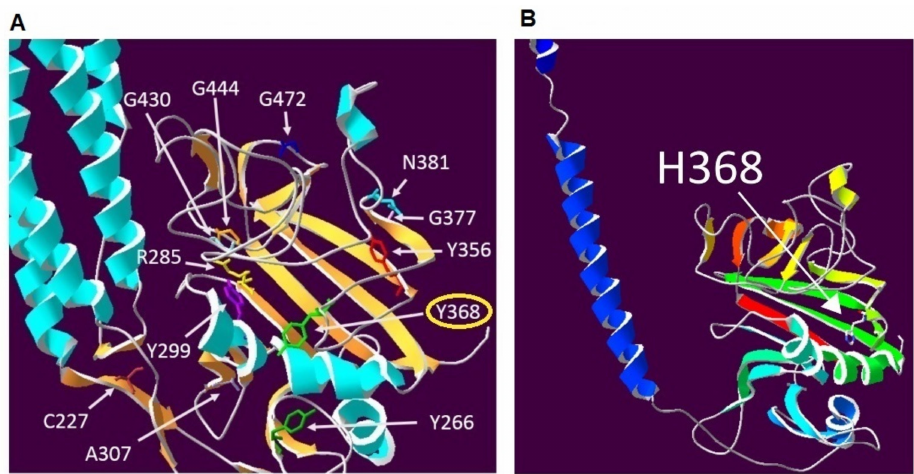
Figure 3. ( A ) The position of novel mutation (Y368H) and others missense mutations in the highly conserved globular C-terminal domain of the fibrinogen β chain, which are at the location of numerous causative mutations for fibrinogen deficiency, including mutations affecting three other tyrosine residues; ( B ) representation of the Fibrinogen beta C-terminus p.Y368H model. (Amino acids are coloured white for carbon, red for oxygen, blue for nitrogen and yellow for sulphur. Secondary structures (helices and strands) are coloured using the DeepView function in Swiss-PdbViewer where the colour reflects the order of each structural element in the overall sequence of residues from the N-terminal to the C-terminal according to the visible spectrum from violet (400 nm) to red (700 nm). Here the first secondary structure shown is a blue helix, the last structure in the sequence is a red strand. Residues which are not part of secondary structures are